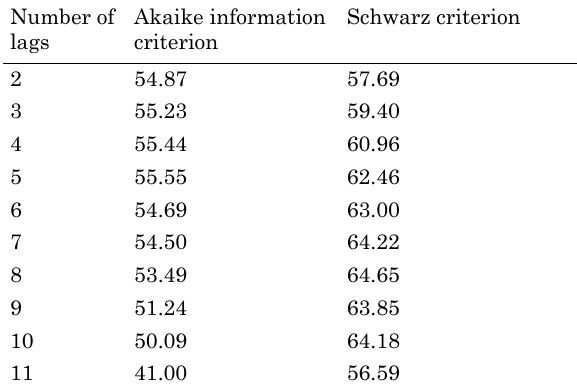
Table 1. Akaike information criterion and